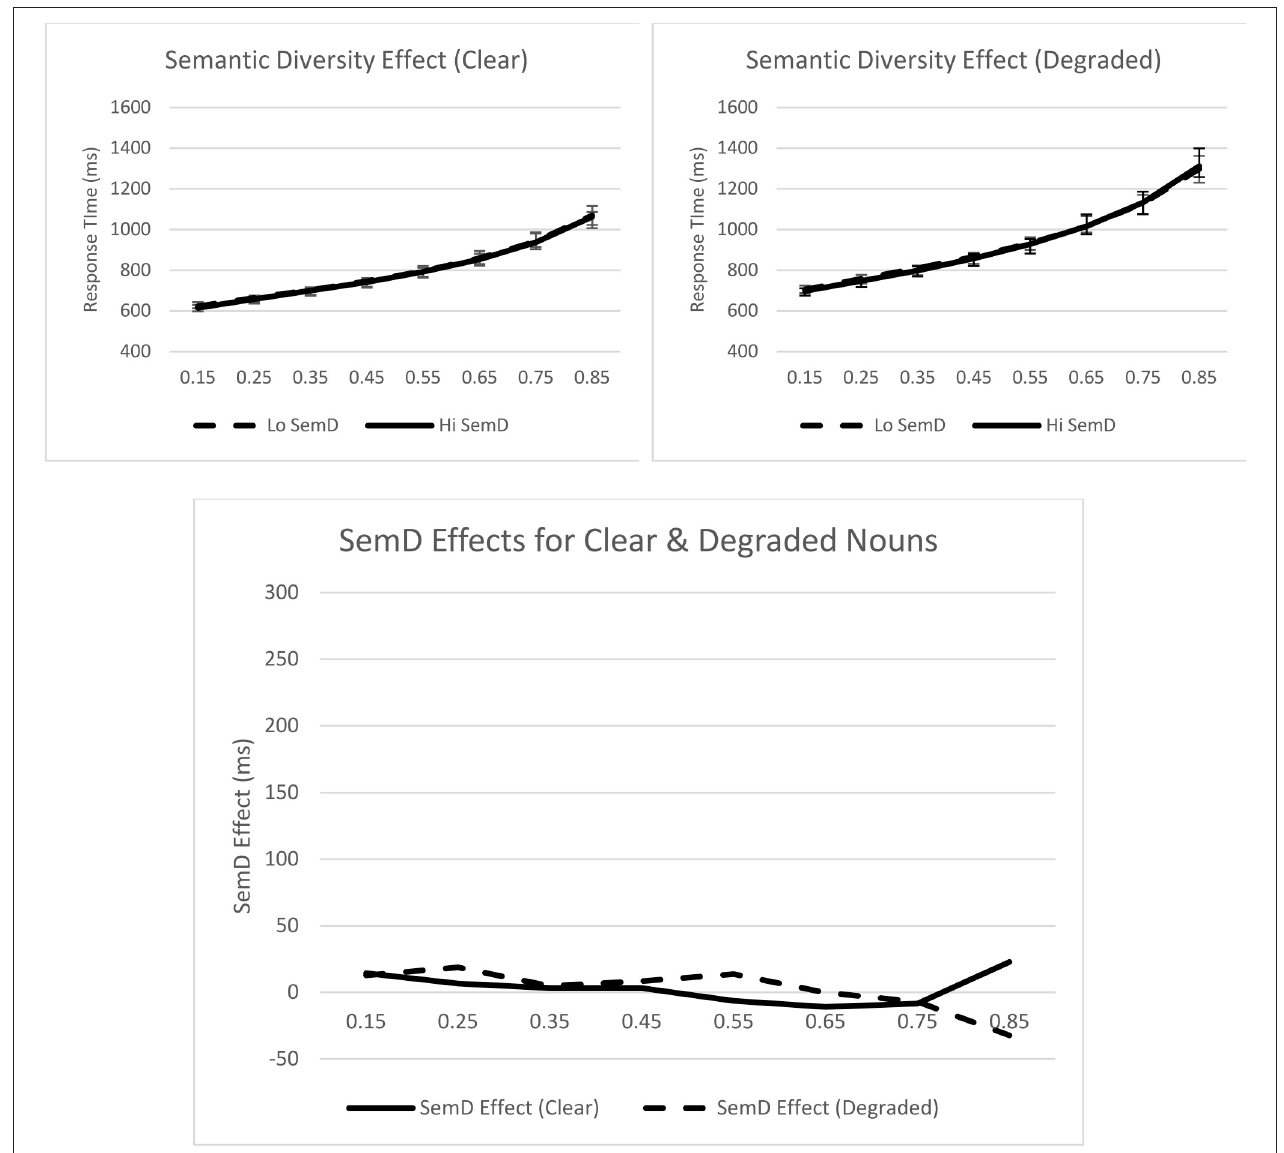
FIGURE 4 | Syntactic classification performance as a function of semantic diversity and quantiles for clear (top left panel) and degraded (top right panel) words. Empirical quantiles are represented by error bars, whereas fitted ex-Gaussian quantiles are represented by lines. The bottom panel shows semantic diversity effects as a function of stimulus quality. SemD, semantic